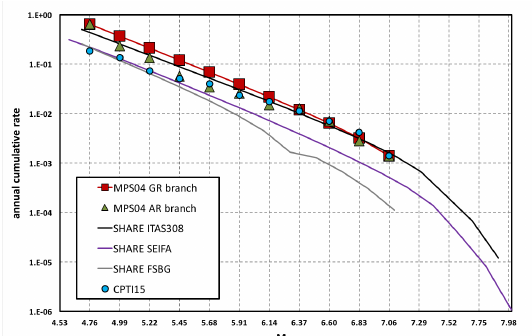
Figure 3. Annual seismicity rates for the two approaches adopted in MPS04 (i.e., GR=Gutenberg-Richter rates; AR=activity rates) for source zone ZS923 and for the three SHARE seismicity models: ITAS308 are the rates associat- ed with the area source, SEIFA are the Kernel-smoothed stochastic rates, FSBG are the rates obtained combining fault sources (for Mw ≥ 6.4) and background seismicity (Mw<6.4). CPTI15 are the rates obtained for source zone ZS923 using the most recent release of the catalogue CPTI15 [Rovida et al.,